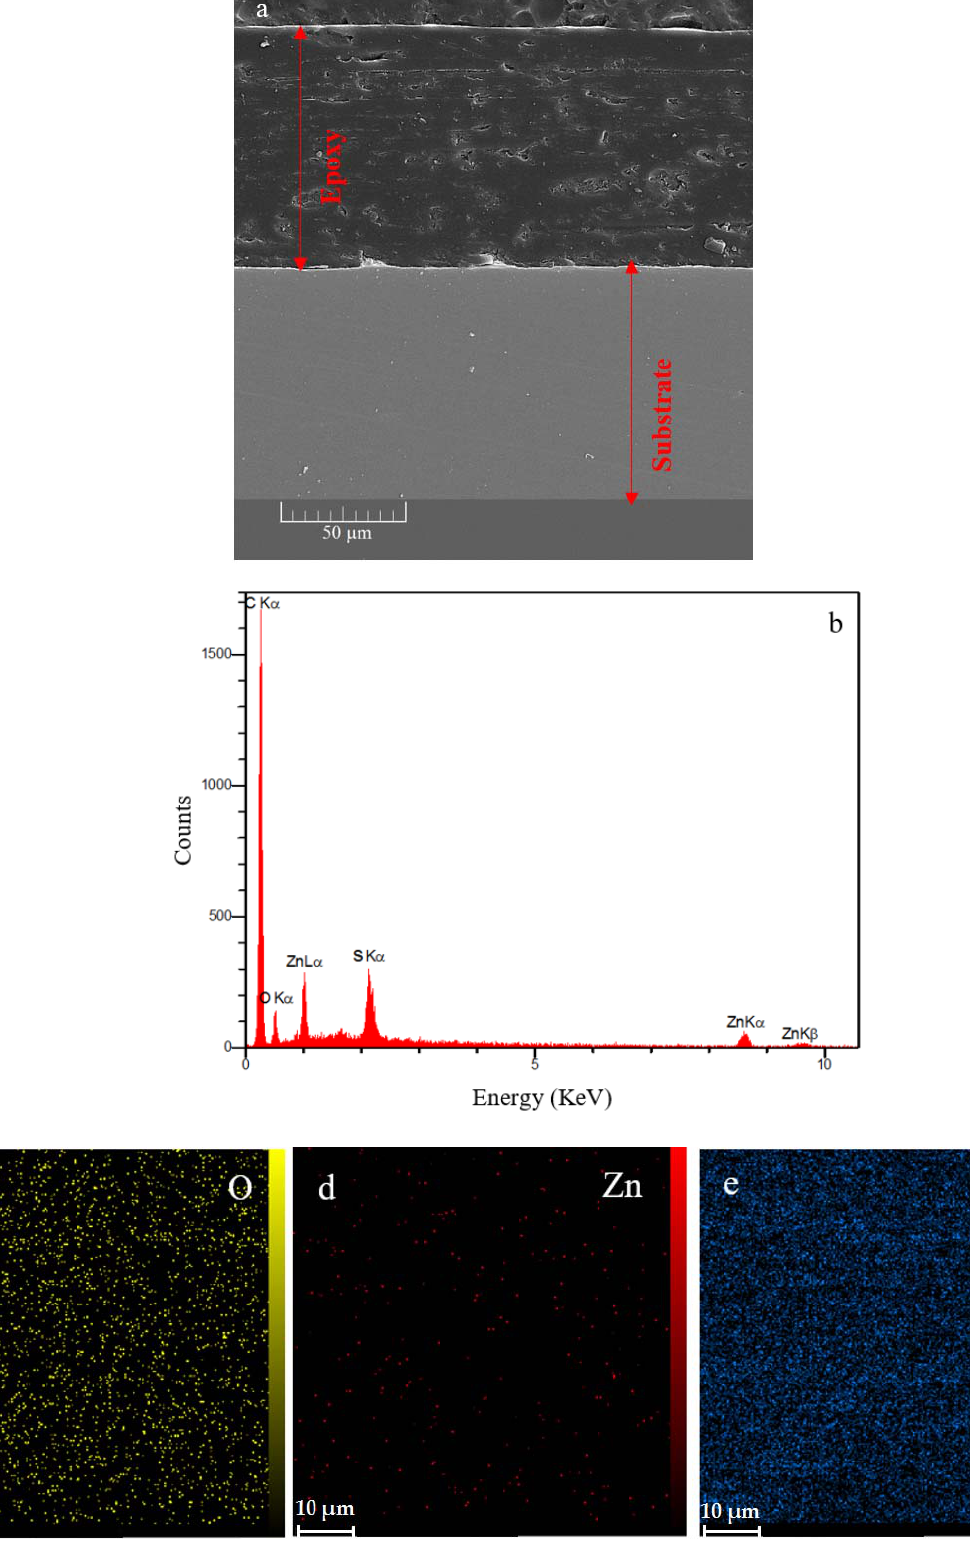
Figure 8. Cross ‐ section area of the ZHS ‐ containing nanocomposite ( a ), together with the corre ‐ Figure 8. Cross-section area of the ZHS-containing nanocomposite ( a ), together with the correspond- sponding EDS spectrum ( b ) and elemental maps ( c – e ). ing EDS spectrum ( b ) and elemental maps ( c – e